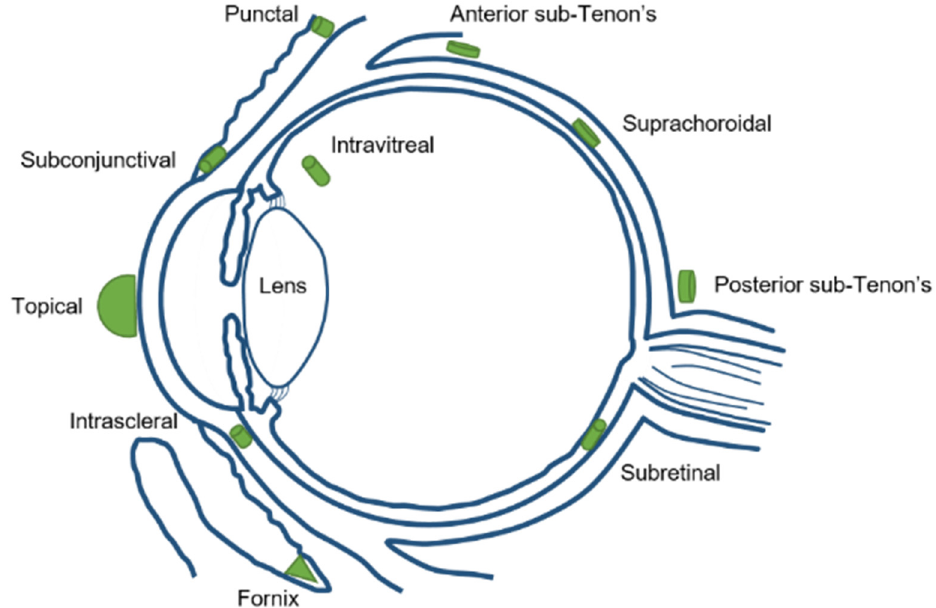
Figure 2. Different ocular drug delivery routes.